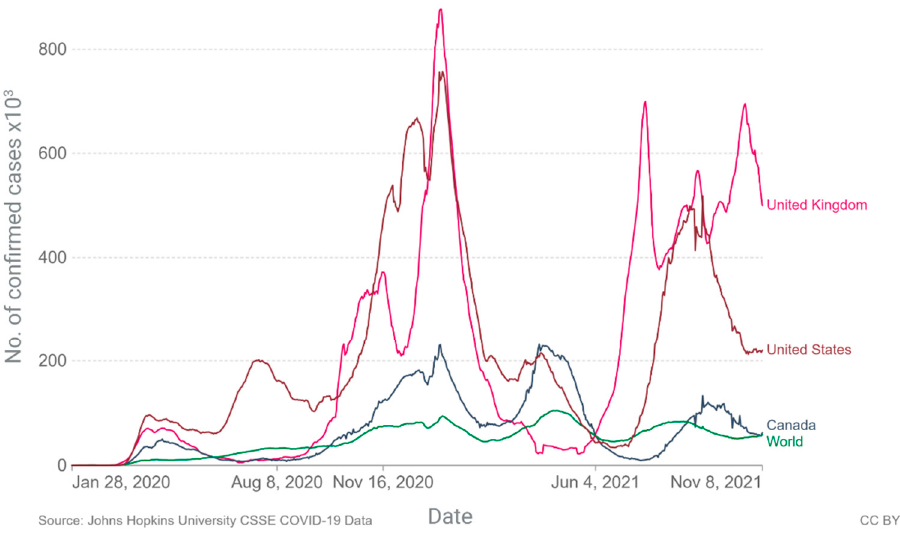
Figure 1. Daily new confirmed COVID-19 cases per million people from January 2020 to November 8. Created with BioRender.com.